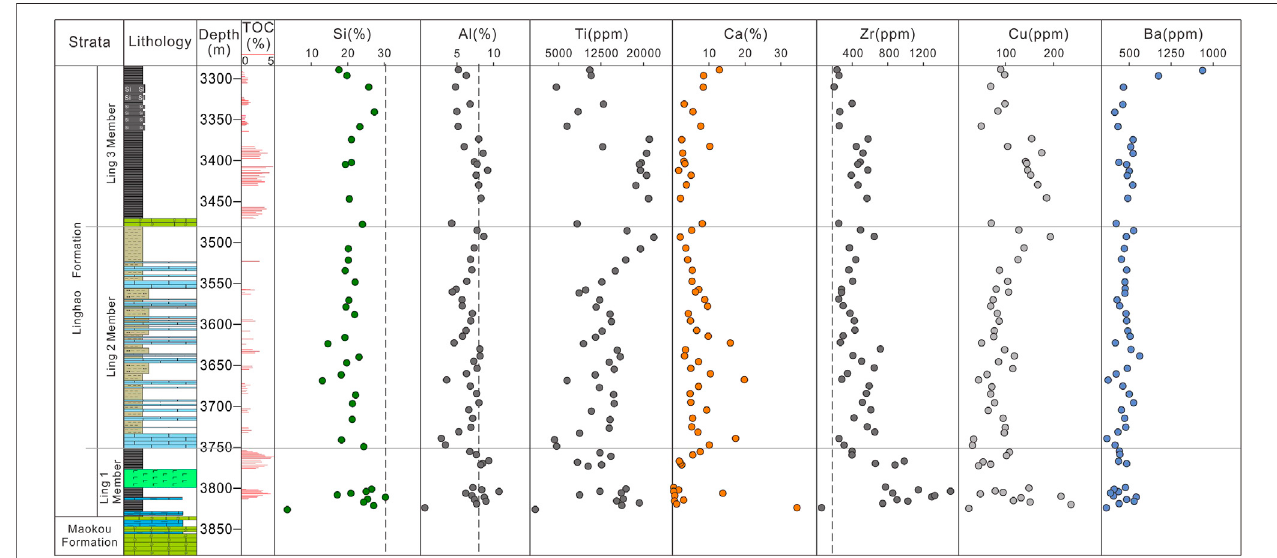
FIGURE 6 | Major and trace elements contents for Linghao Formation marine shale from the studied well in the central Nanpanjiang basin (1). Dashed lines represent the upper continental crust value for the corresponding element (McLennan, 2001)